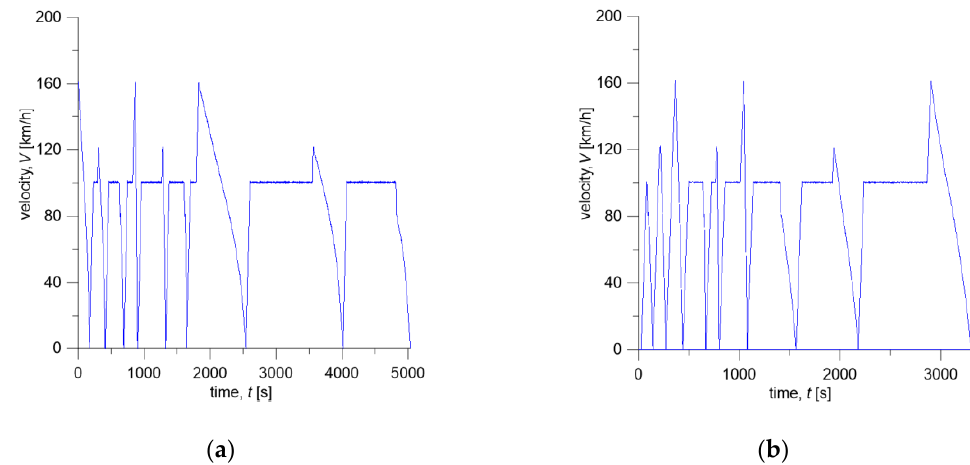
Figure4. Changesinsimulatedvelocity V ofthevehicleduringbrakingfor: ( a )MaterialA;( b Figure 4. Changes in simulated velocity V of the vehicle during braking for: ( a ) Material A; ( b ) Material B.